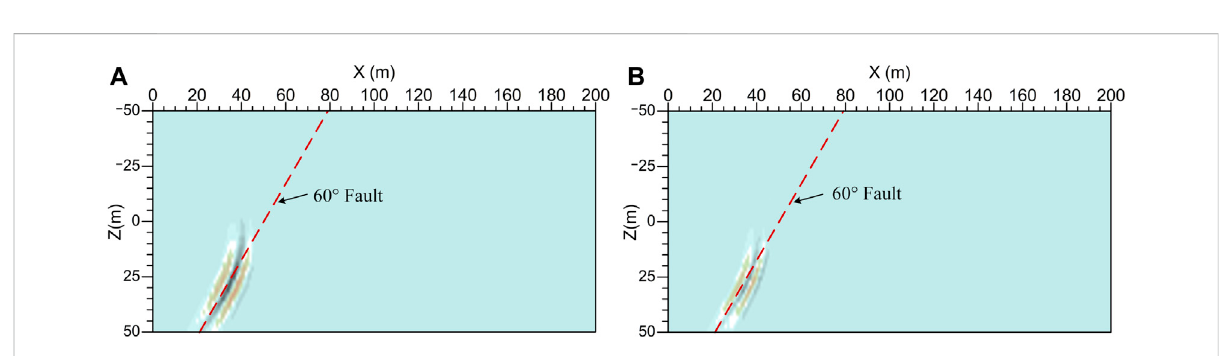
FIGURE 8 Multi-wave sections of the 60 ° dip roadway fault model. (A) Section of PP waves; (B) Section of SS waves.